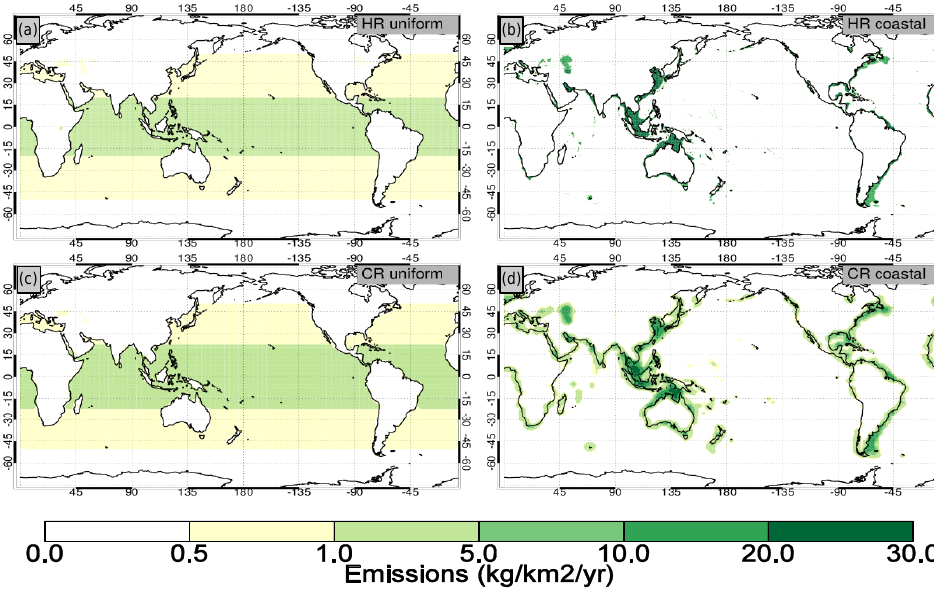
Figure 1. Tracer emission fields of CHBr 3 used in the model runs described here: (a) uniform tracer and (b) coastal tracer in high-resolution run; (c) uniform tracer and (d) coastal tracer in coarse-resolution